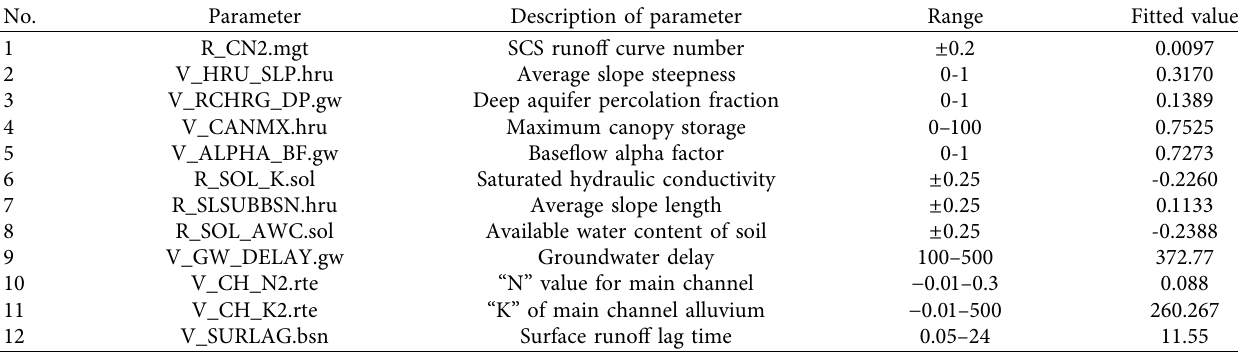
Table 5: Summary of calibrated best flow parameters.